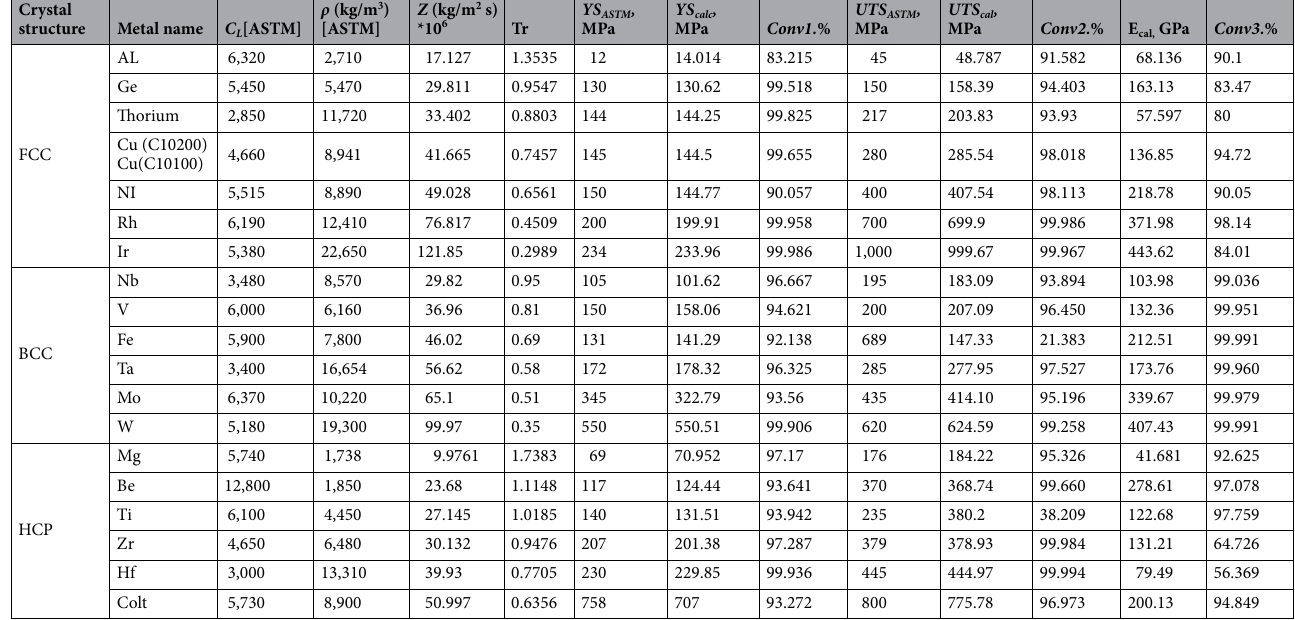
Table 1. Mechanical properties classification of pure metals according to their crystal structure 25–27